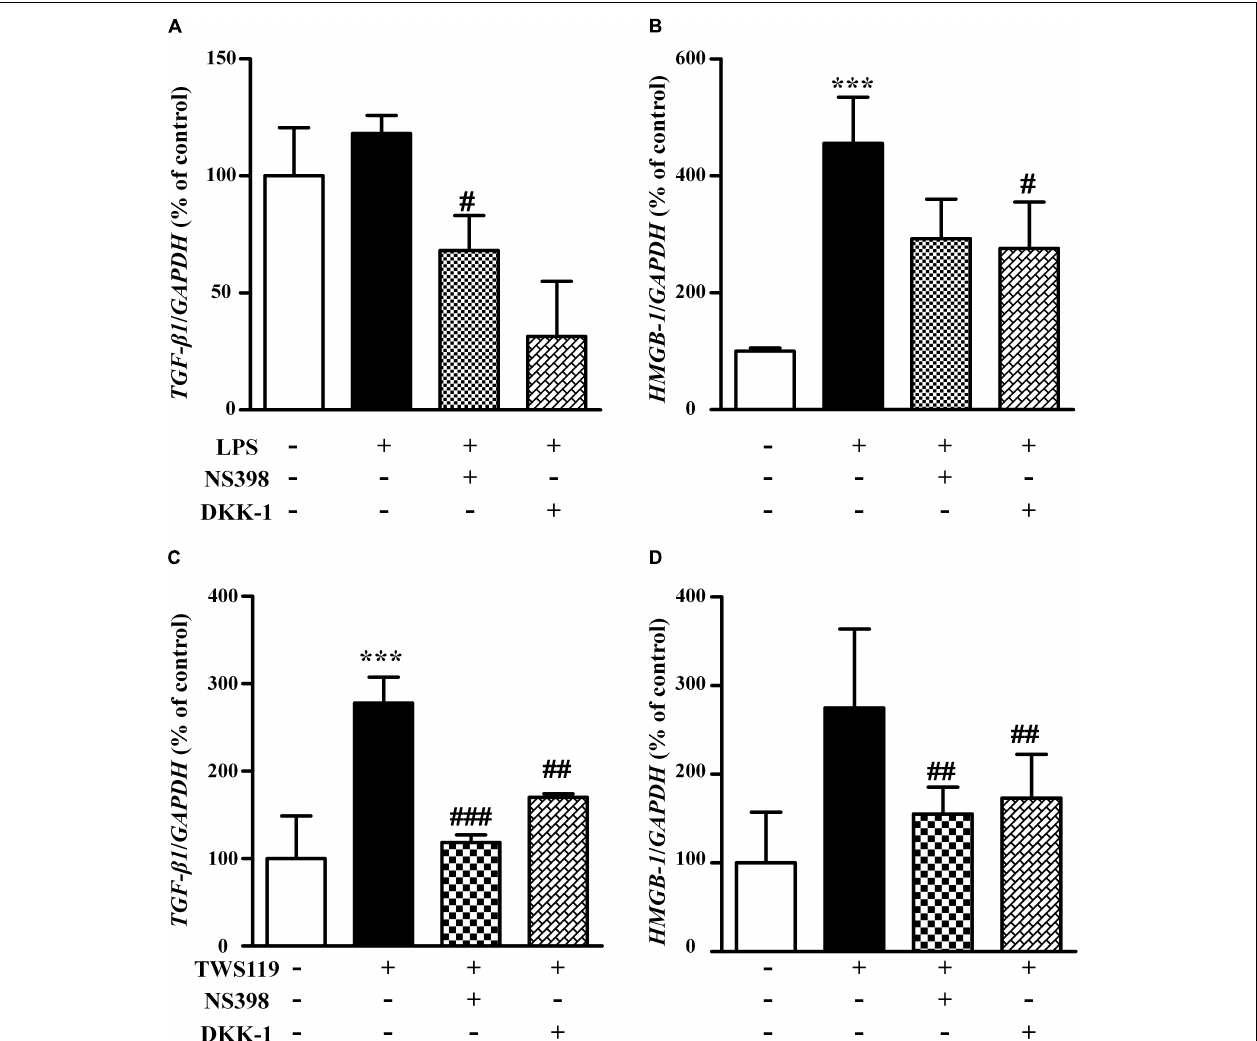
FIGURE 8 | The mRNA levels and quantitative analysis of TGF- β 1 and HMGB-1 in the NIH3T3 cells treated with LPS or TWS119. The mRNA levels and quantitative analysis of TGF- β 1 (A) or HMGB-1 (B) in NIH3T3 cells treated with or without LPS plus NS398 or LPS plus DKK-1. The mRNA levels and quantitative analysis of TGF- β 1 (C) or HMGB-1 (D) in NIH3T3 cells treated with or without TWS119 plus NS398 or TWS1119 plus DKK-1. ∗∗∗ P < 0.001 vs. the control; # P < 0.05, ## P < 0.01, and ### P < 0.001 vs. the LPS group,